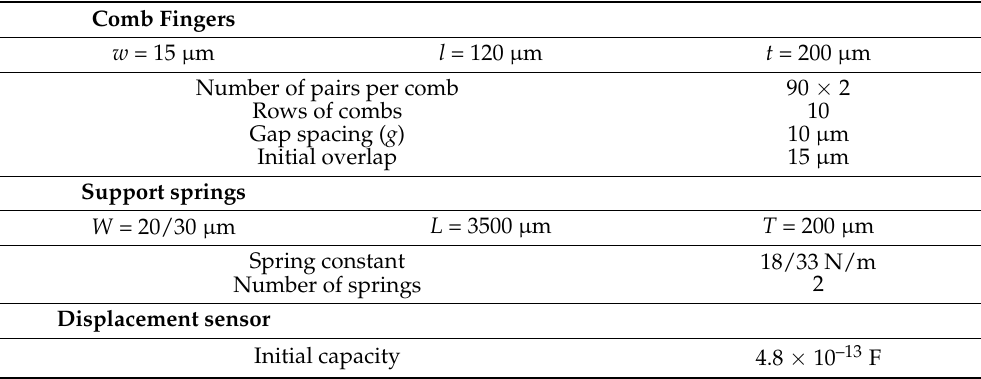
Table 1. Design parameters of the comb-drive